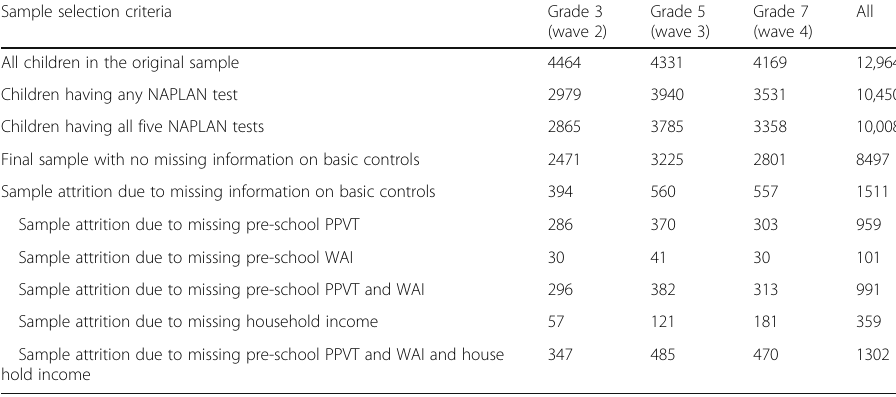
Table 6 Sample attritions Sample selection criteria